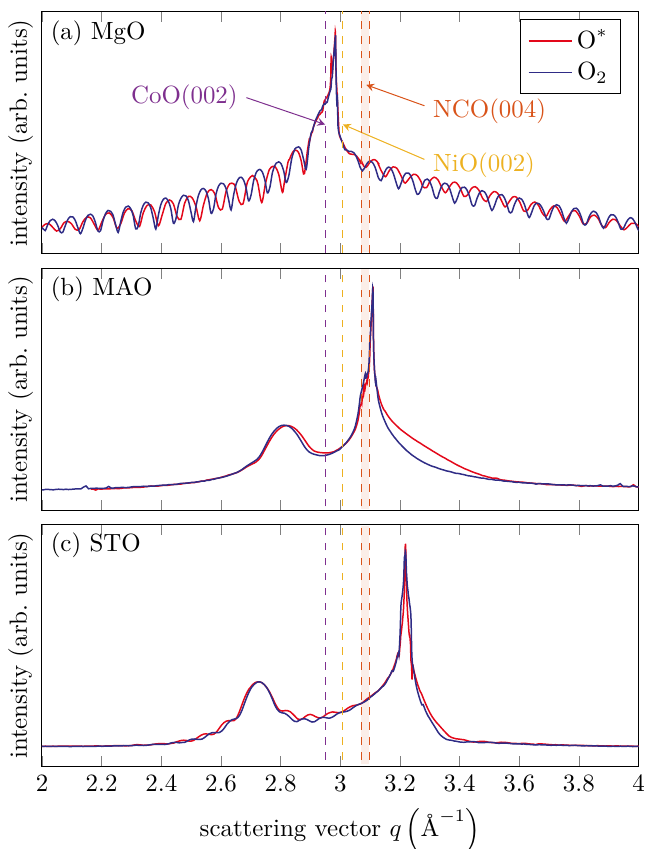
Figure 5. XRD measurements of the (00L) CTR across the ( a ) MgO(002), ( b ) MAO(004) and ( c ) STO(002) Bragg reflections. Dashed lines indicate the theoretical CoO(002) and NiO(002) Bragg peak positions for bulk material. Due to the possible lattice constants, a range of potential Bragg peak positions emerges for NCO(004). For ( a ) the film peak position agreed well with the theoret- ical value of CoO(002). In contrast, the film peak position for ( b , c ) show no agreement with the theoretical values.